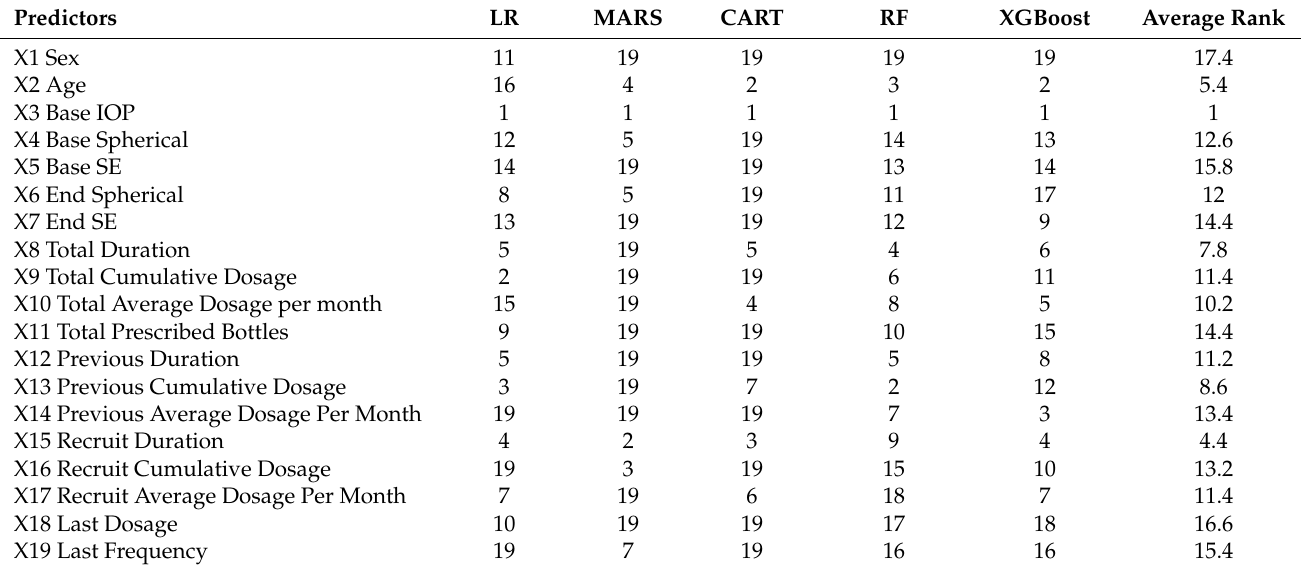
Table 5. Importance rank of each predictor using the five methods.